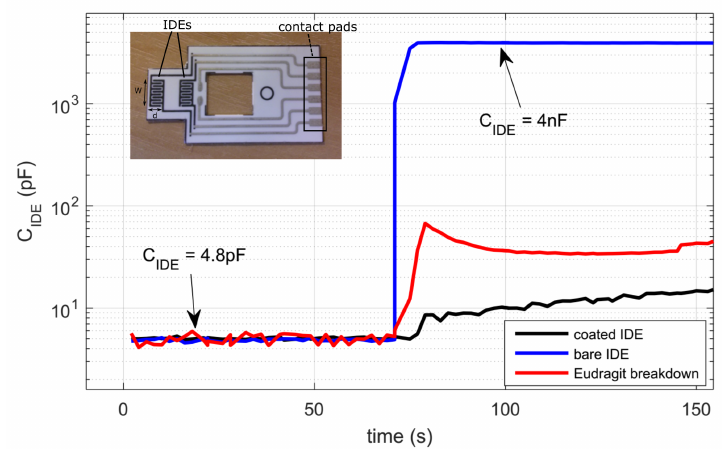
Figure 2. Example of measured capacitance over time of an IDE test strip shown in the figure inset. The average values of the capacitance are reported in the text for different types of IDEs. For convenience, only the first 150 s of measurement are shown. The values reported in the text refer to the steady state value after 1800 s. Each IDE test strip consists of two equal IDEs with an overall area (W × d) of 3 × 5.5 mm 2 . Each IDE consists of five digits of a length of 2 mm, a width of 0.3 mm and a spacing of 0.3 mm. The distance between the IDEs is 3